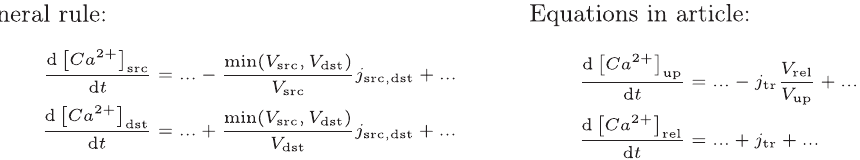
Fig 4. Comparison between general rule for inactive transport equations (left) and actual equations occurring in the article by Inada et al . (right). The right-hand side is the result of substituting src = up and dst = rel in the left- hand side and then simplifying due to min( V up , V rel ) = V rel . If only the right-hand side is given, it is not trivial to trace back these steps to arrive at the general rule, which is required to understand the meaning of the equation. The name “tr” does not immediately make it apparent what are the source (src) and destination (dst) concentrations affected